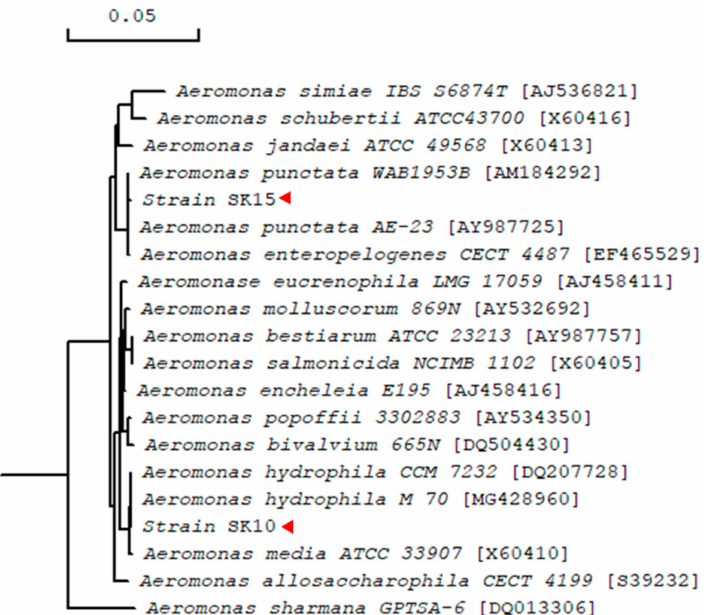
Figure 2. Phylogenetic tree of Aeromonas isolates SK10 and SK15 based on their 16S rRNA sequences. The phylogenetic tree was constructed using observed divergence method with bootstrap trials of 1000 in